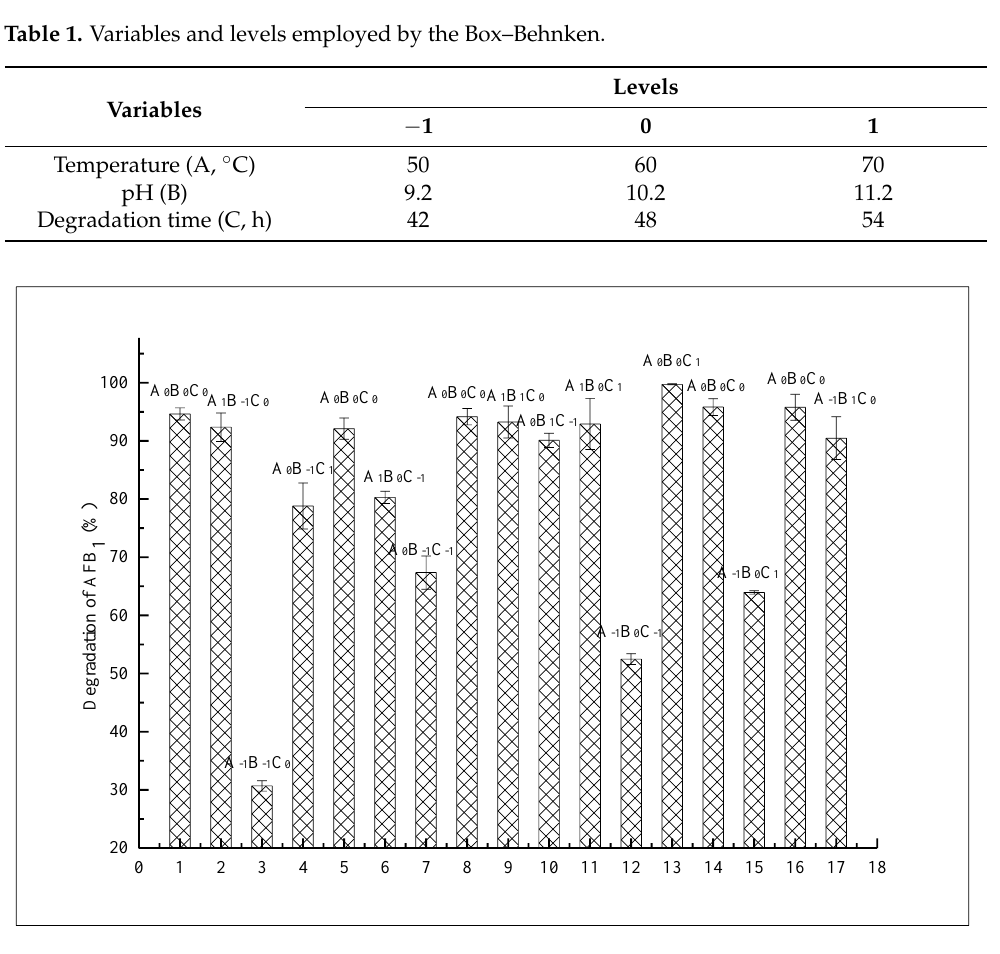
Figure 2. Results of response surface experiment. Note: The abscissa represents the 17 tests. In the figure, A, B, and C represent the test factors temperature, pH, and degradation time, respectively. The numbers at the lower right foot of the letter − 1, 0, 1 represent the three levels of the factors, respectively.